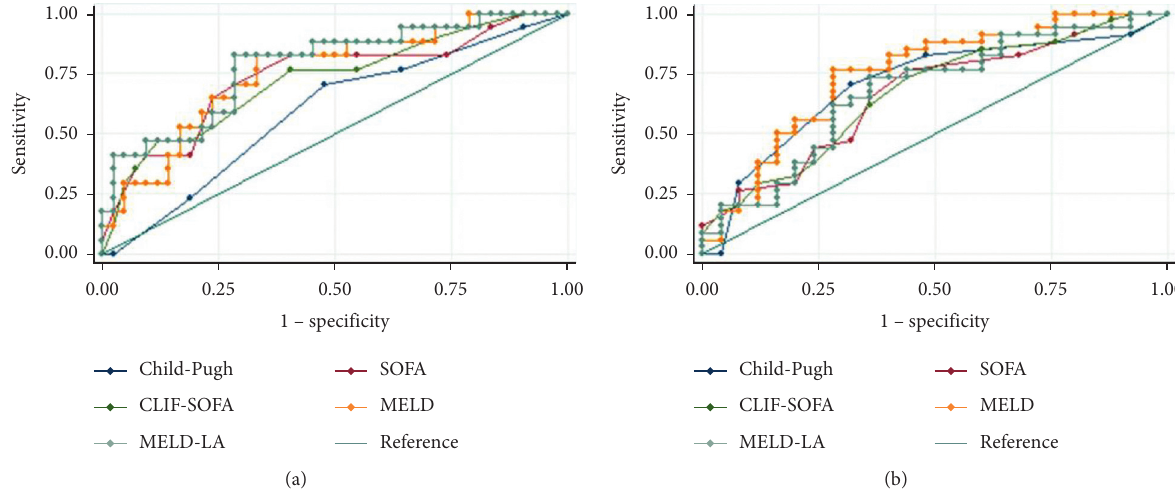
Figure 2: Receiver operating characteristic curves of the scoring systems for (a) 15-day and (b) 5-year mortality in critically ill patients with cirrhosis caused by both alcohol and hepatitis. SOFA, sequential organ failure assessment; CLIF-SOFA, chronic liver failure-sequential organ failure assessment; MELD, model for end-stage liver disease; MELD-LA, model for end-stage liver disease-lactate.